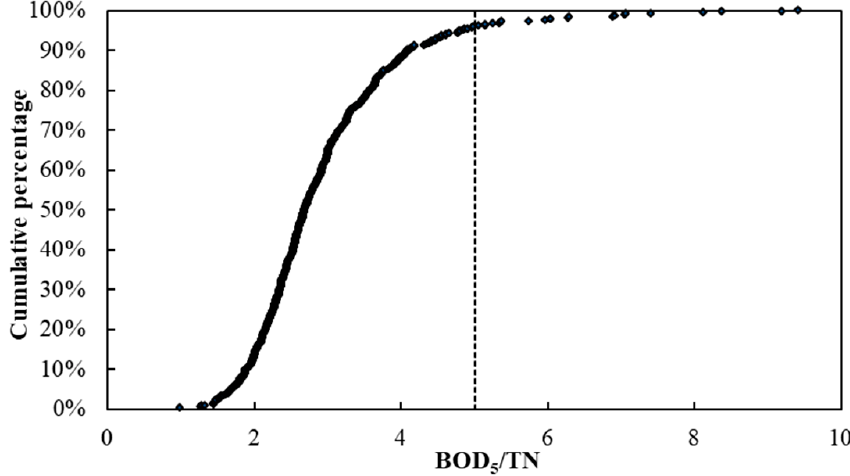
Figure 6. BOD 5 /TN cumulative distribution in the CAST process.